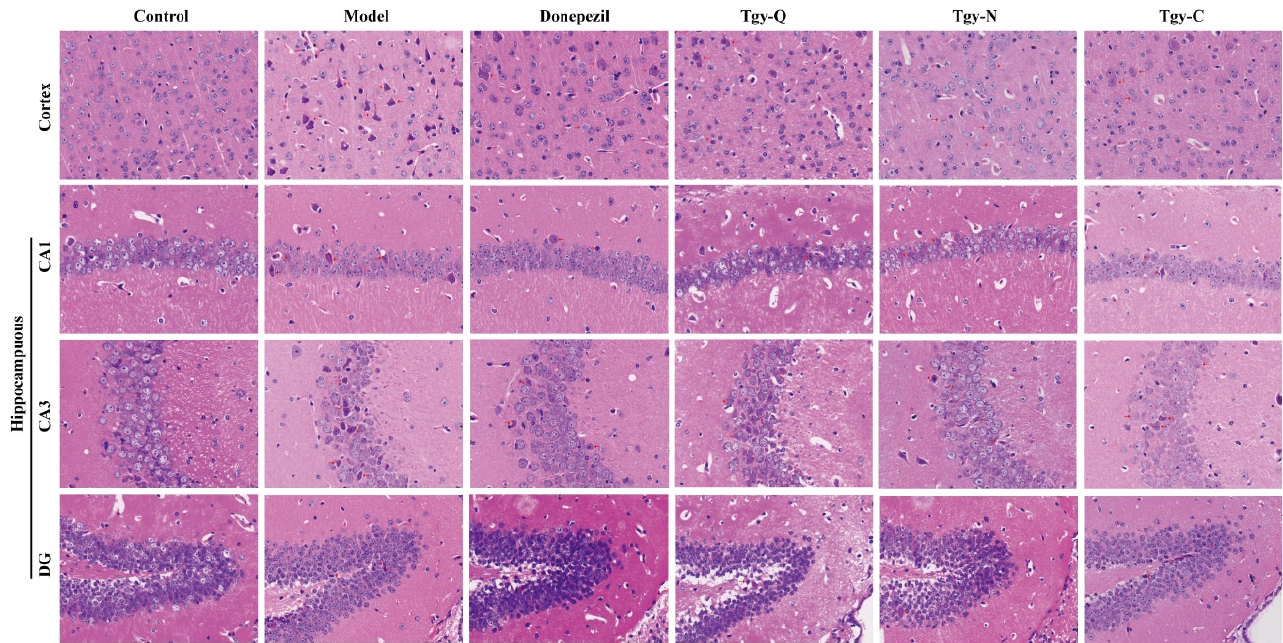
Figure 3. Effect of Tieguanyin extracts treatment on neuronal loss and death in the cortex and in the hippocampus by HE staining in the cortex and hippocampus (CA1, CA3, DG) of the wild-type mice and the APP/PS1 mice treated with normal saline, Tgy-Q, Tgy-N,Tgy-C, or Donepezil (0.1 mg/kg). n = 3 for each group.